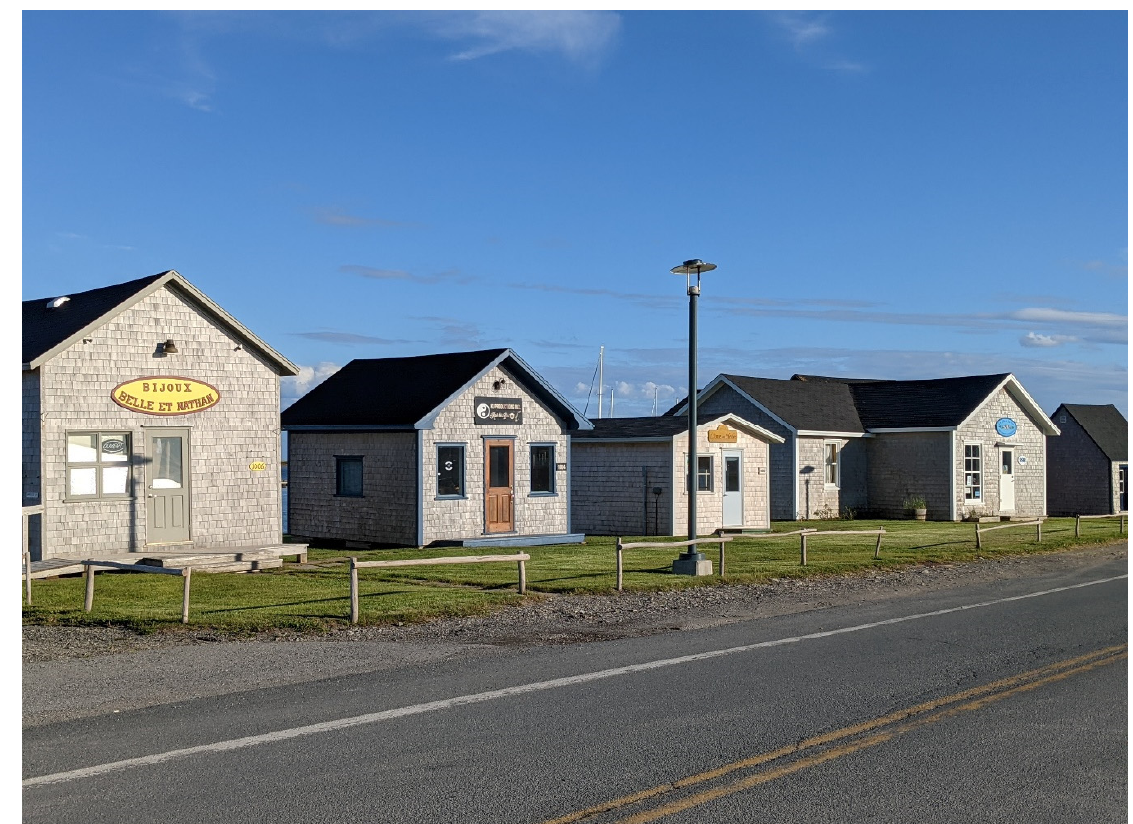
Figure 4. Tourism Boutique at the La Grave historical site (Photography by Dominic Lapointe).